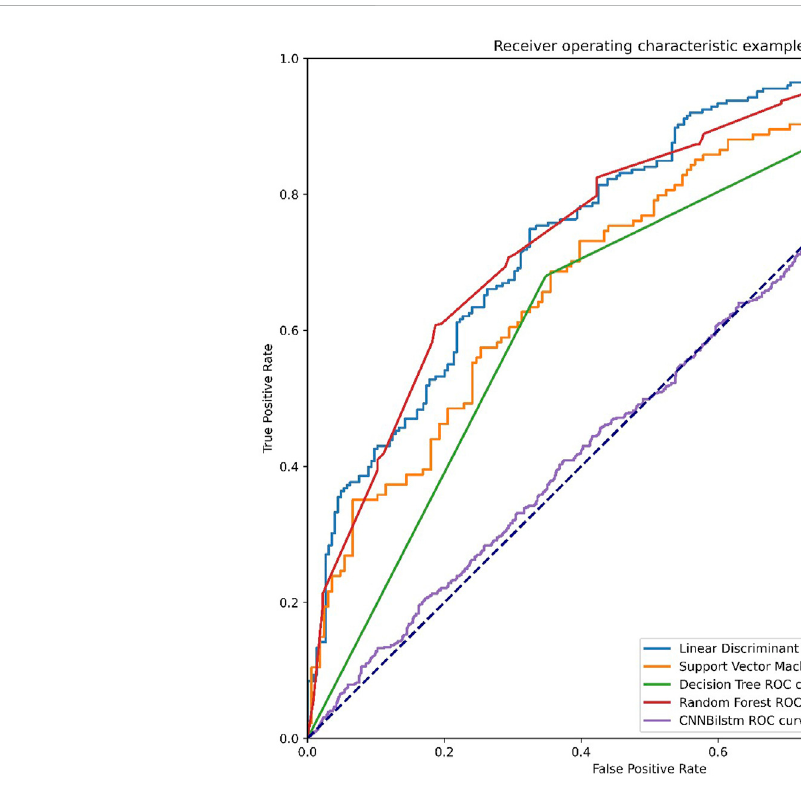
FIGURE 6 The ROC curves of DDE feature.